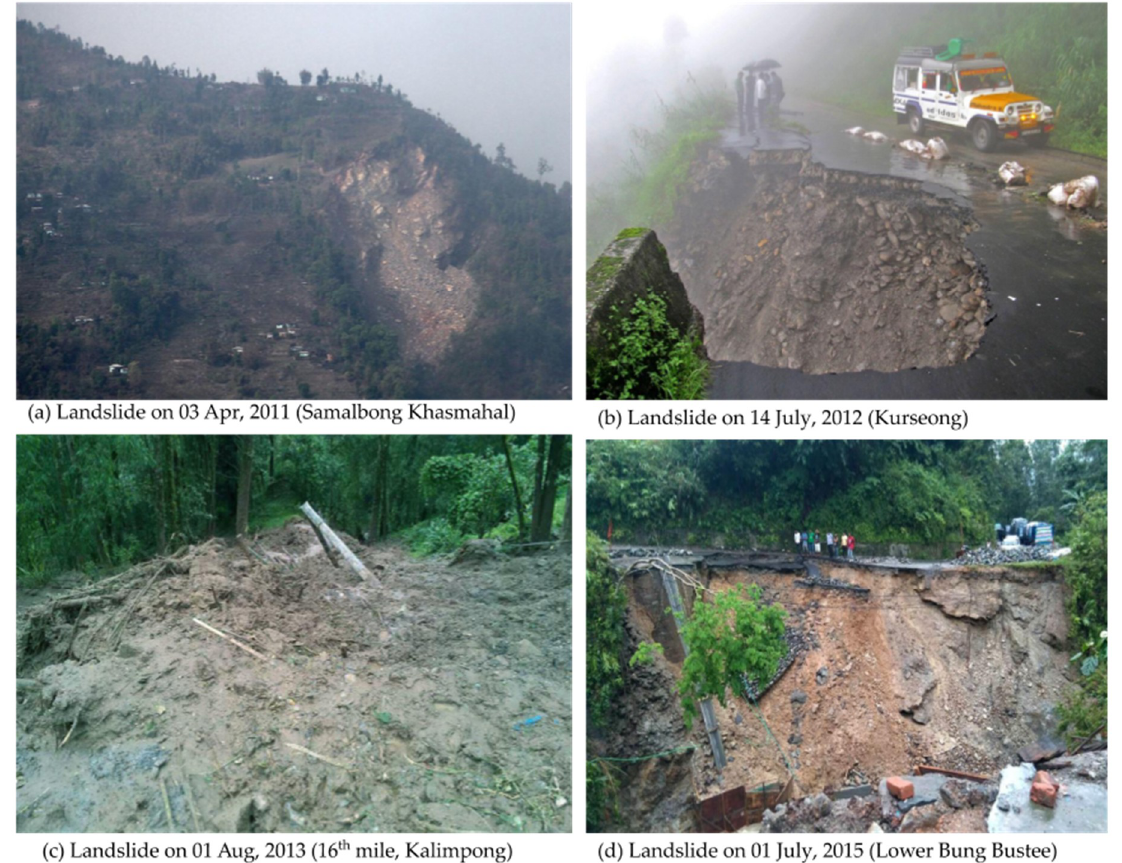
Figure 2. Landslide damage in the region during various rainfall events (Source: Save The Hills).